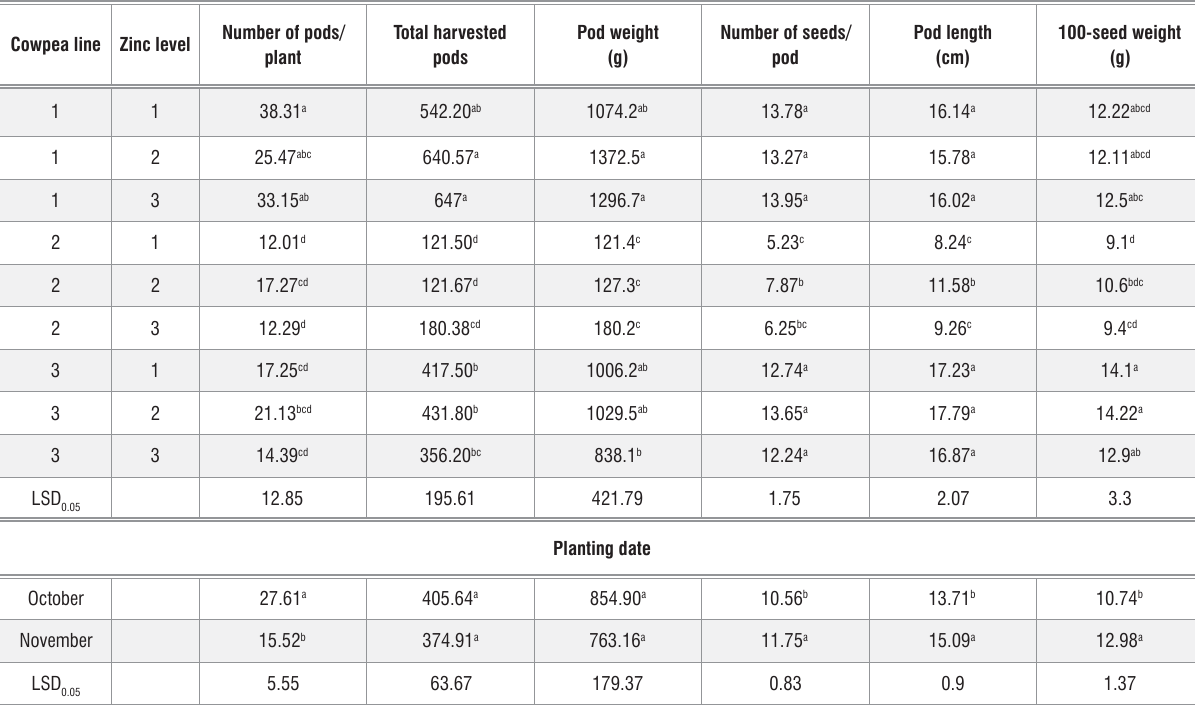
Cowpea line Zinc